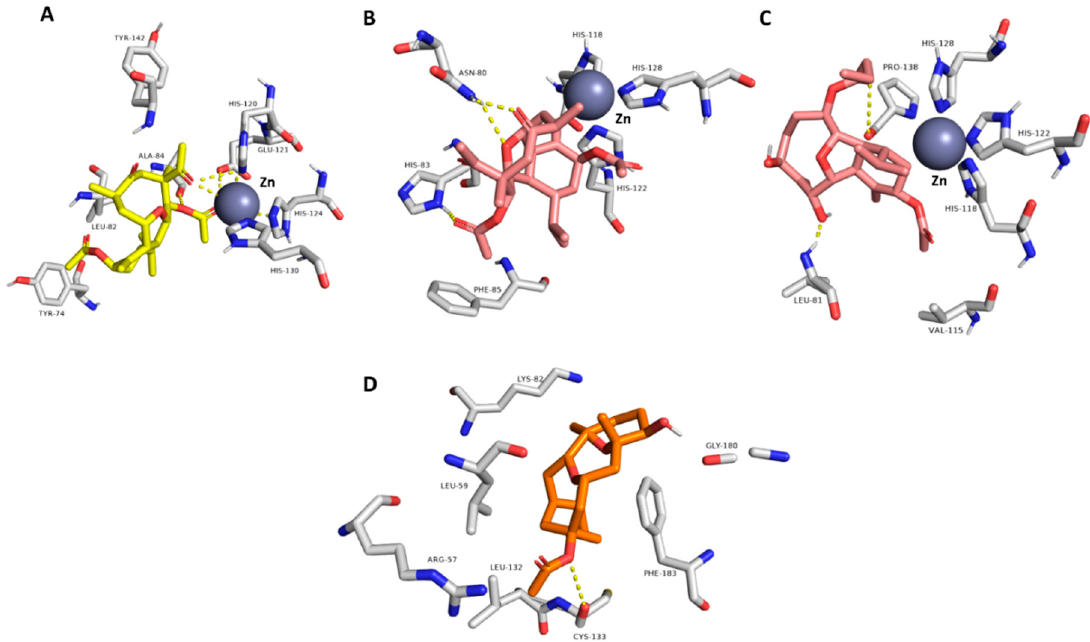
Figure 16. ( A ) Binding mode of compound 7 inside the active site of matrix metalloproteinase-2 (MMP2; yellow-colored compound); ( B , C ) binding modes of compounds 7 and 8 , respectively, inside the active site of matrix metalloproteinase-1 (MMP1; red-colored compounds); ( D ) binding mode of compound 12 inside the active site of serine/threonine-protein kinase PLK1 (PLK1; orange-colored compound). All of these binding modes were the last snapshot derived from MDS of each compound-protein complex.